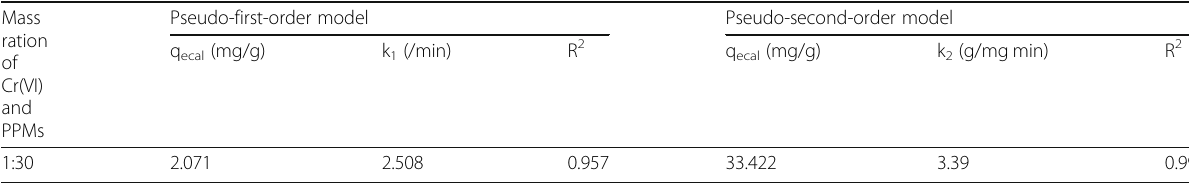
Table 3 Kinetic adsorption model fitting data